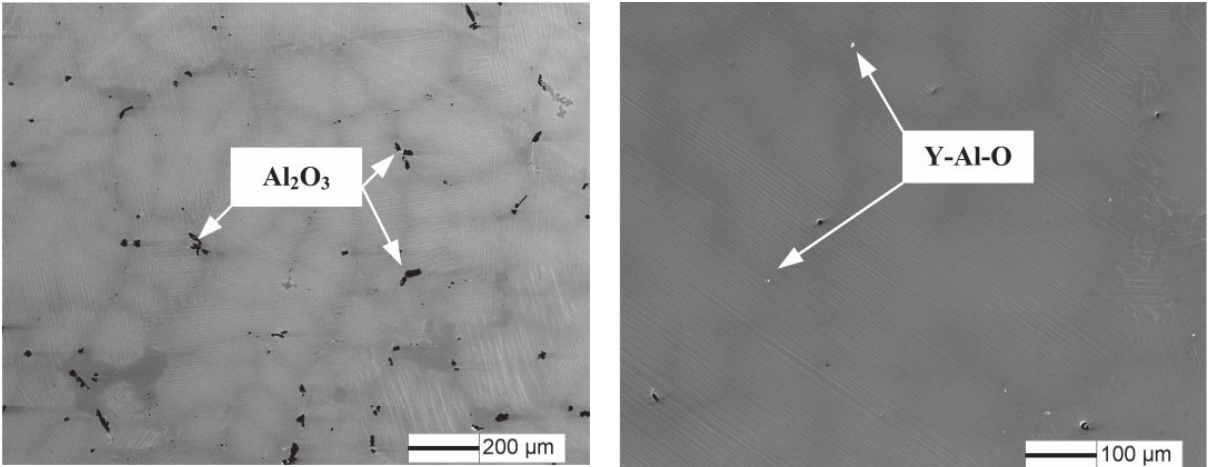
Fig. 7: Inclusions inside the alloy matrix obtained by alumina mould.